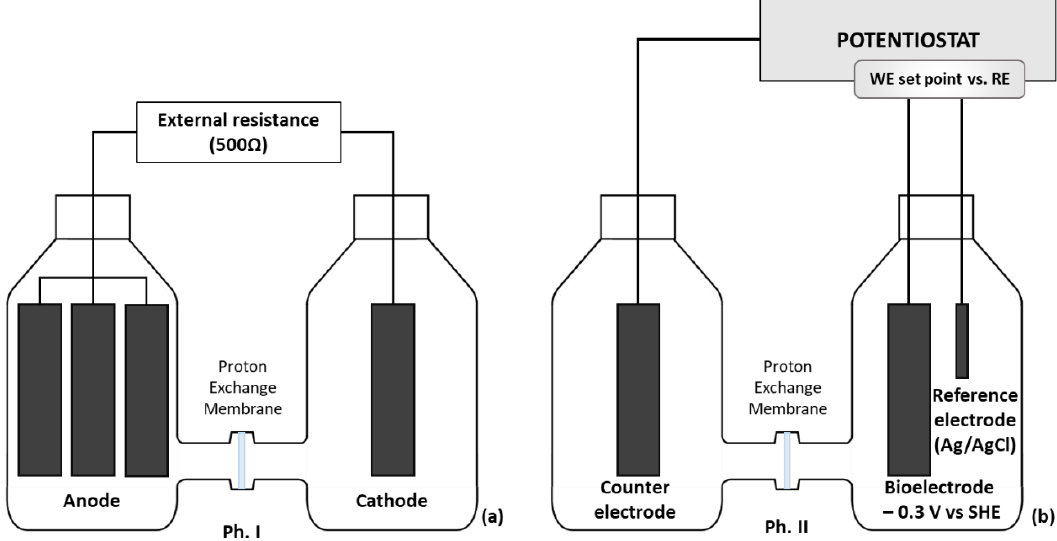
Figure 1. Schematic diagram of the reactors used in the present study. ( a ) In the acclimatization phase (Ph. I) of the electroactive biofilm (MFC), anode and cathode were connected by a 500 Ω external resistance. ( b ) In the second phase (Ph. II), in the polarized reactor (POL −0.3 V) and in the abiotic polarized control (ABI −0.3 V), a potential of −0.3 V versus SHE was imposed.